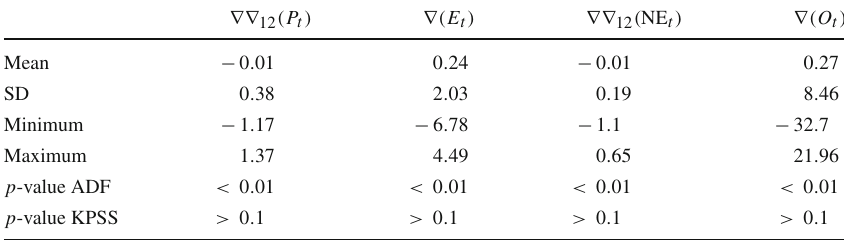
Table2 Descriptive statistics for the stationary series of total ( P t ) , energy ( E t ) and non-energy ( NE t ) CPIs in Spain and Brent price ( O t ) , Sample: 2003.02–2020.02